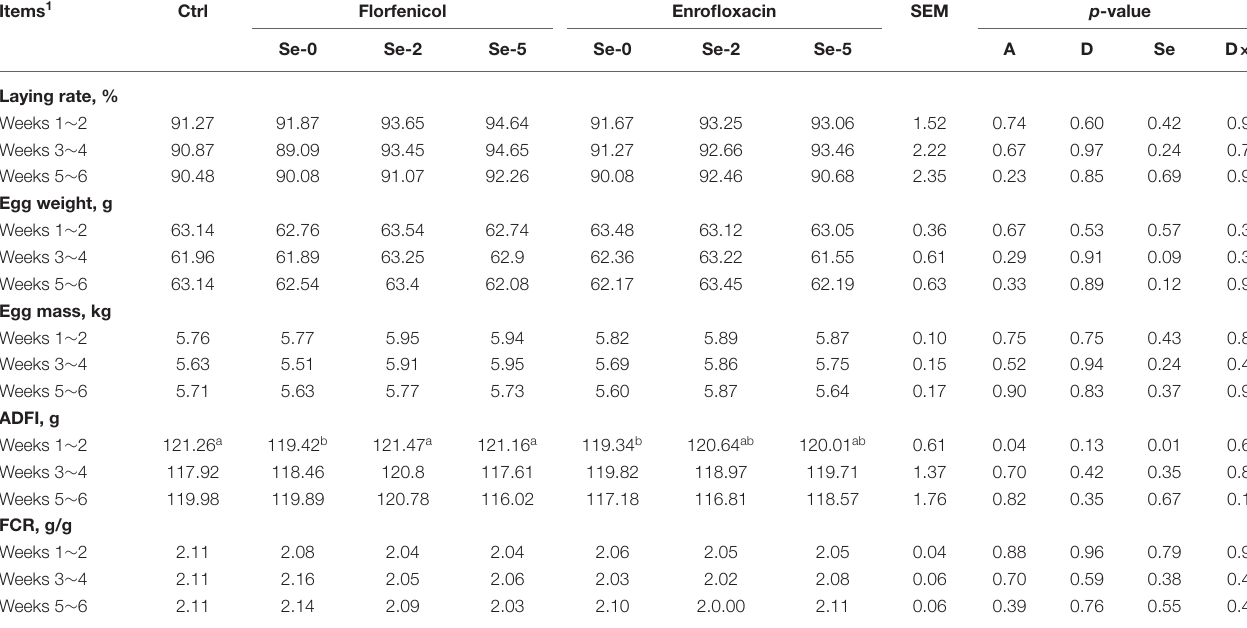
TABLE 3 | Effects of dietary organic selenium on performance of laying